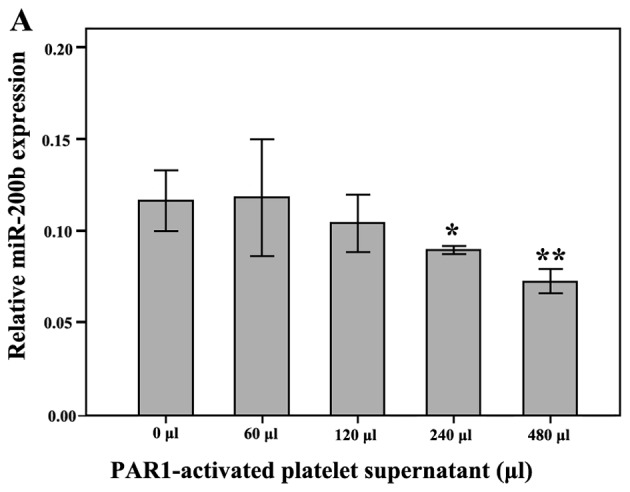
Expression of miR-200b of the SW620 treated with different volumes of the PAR1-activated platelet supernatant detected by qPCR at (A) 24 or (B) 48 h. (a) after 24 h the groups treated with 60 and 120 μl of platelet supernatant did not indicate significant difference (P>0.05) compared to the control group, whereas those treated with 240 and 480 μl showed a significantly lower miR-200b expression. *P<0.05 and **P<0.01. PAR1, protease-activated receptor-1.